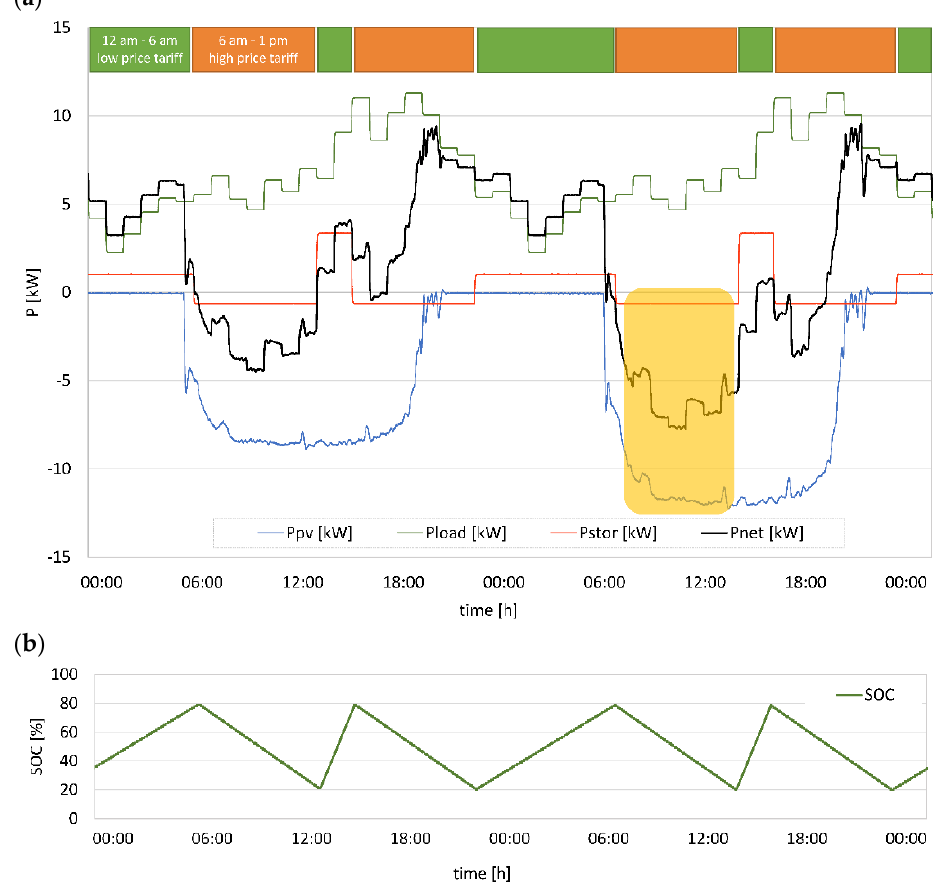
Figure 4. Results of reference scenario. Green and orange colors represent periods of low and high-price tariffs, respectively. The yellowish rectangle highlights the example of the increased reverse power flow in the feeder (P net ) due to PV (P PV ) ESS (P stor ).